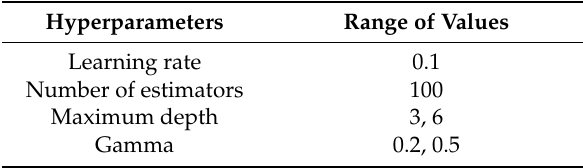
Table 5. Hyperparameters used for XGBoost tree in current